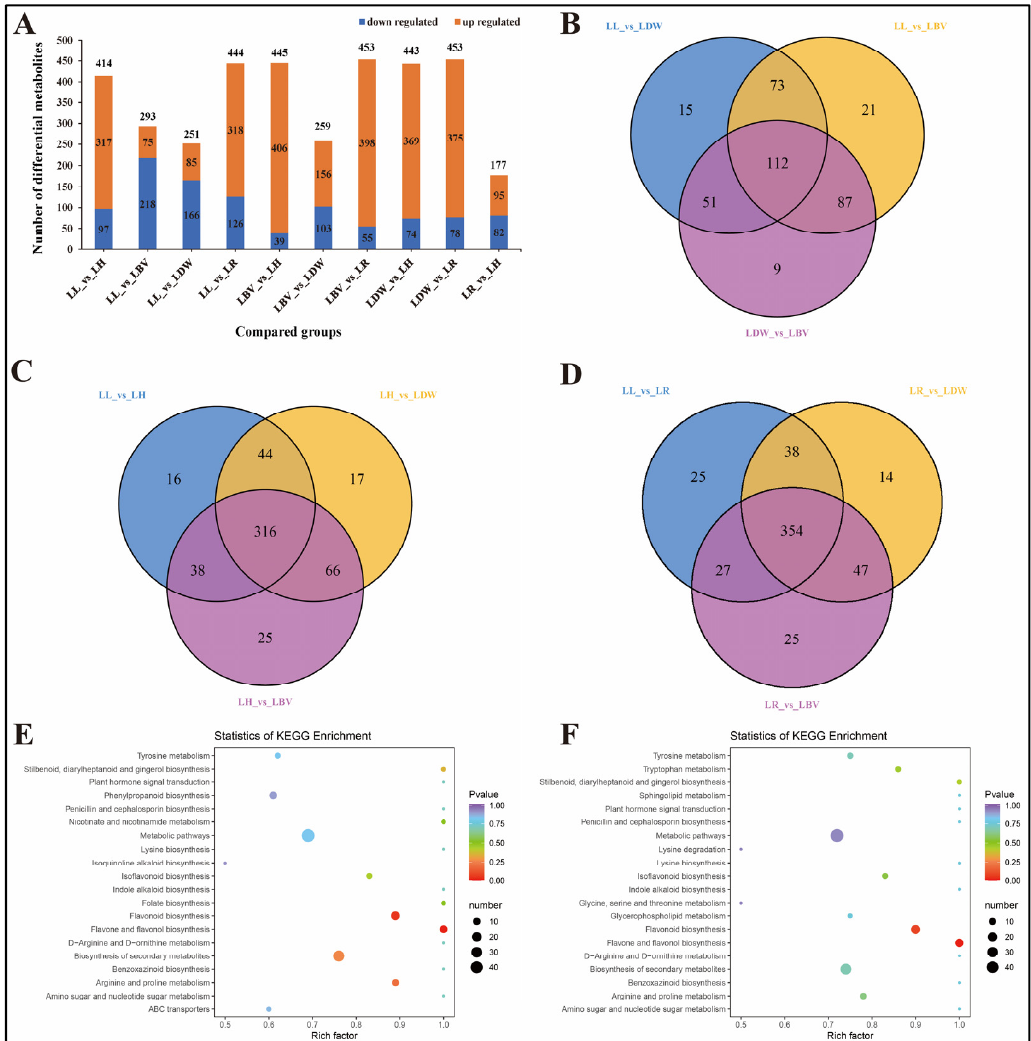
Figure 3. Differentially accumulated metabolites (DAMs) analysis. LR: L. regale , LH: L. henryi , LL: L. lancifolium , LDW: L. davidii var. willmottiae , LBV: L. brownii var. viridulum . ( A ) Bar graph of up- and downregulated DAMs from pairwise comparisons. ( B ) Venn graph for DAMs from the pairwise comparisons of traditional medicine and food used lilies (LL vs. LDW, LL vs. LBV and LDW vs. LBV). ( C ) Venn graph for DAMs from the pairwise comparisons between LH and three traditional medicine and food used lilies (LL vs. LH, LH vs. LBV and LH vs. LDW). ( D ) Venn graph for DAMs from the pairwise comparisons between LR and three traditional medicine and food used lilies (LL vs. LR, LR vs. LBV and LR vs. LDW). ( E ) Top 20 enriched KEGG pathways of DAMs in LL vs. LH. ( F ) Top 20 enriched KEGG pathways of DAMs in LL vs. LR.